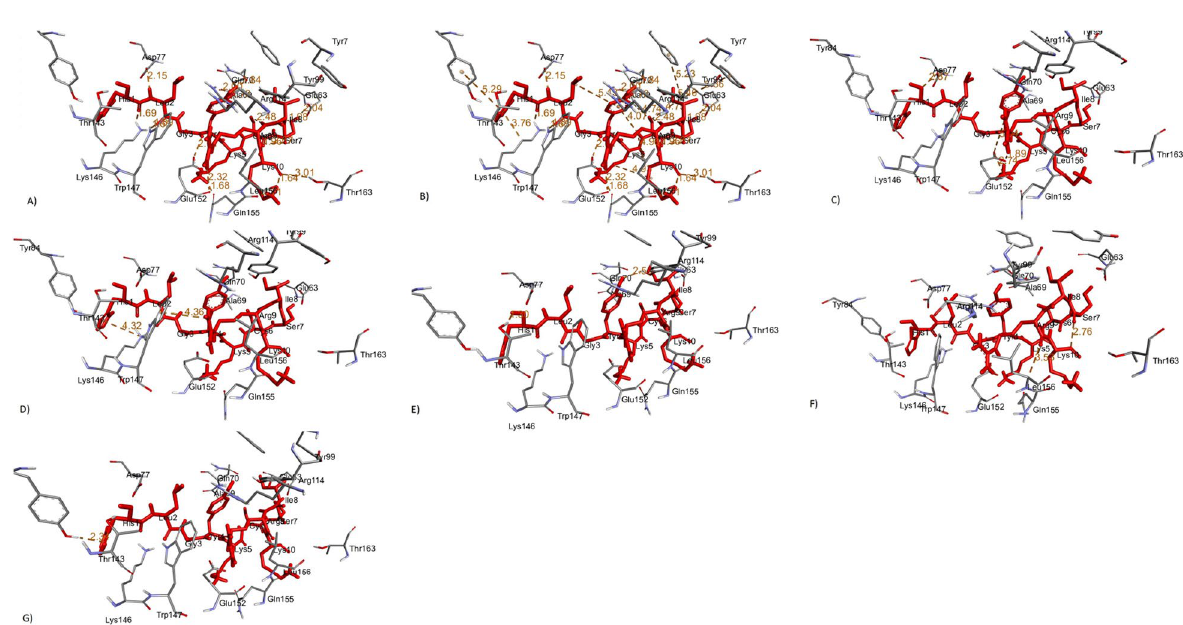
Figure 2. Different Interactions between the epitope and its corresponding MHC allele visualized using the discovery studio. ( A ) Conventional Hydrogen Bonds ( B ) Hydrophobic Interactions ( C ) Salt Bridge, attractive Charge interactions ( D ) Cation-Pi interactions ( E ) Donor-Donor Clash ( F ) Carbon Hydrogen Bond ( G ) Pi Donor Hydrogen